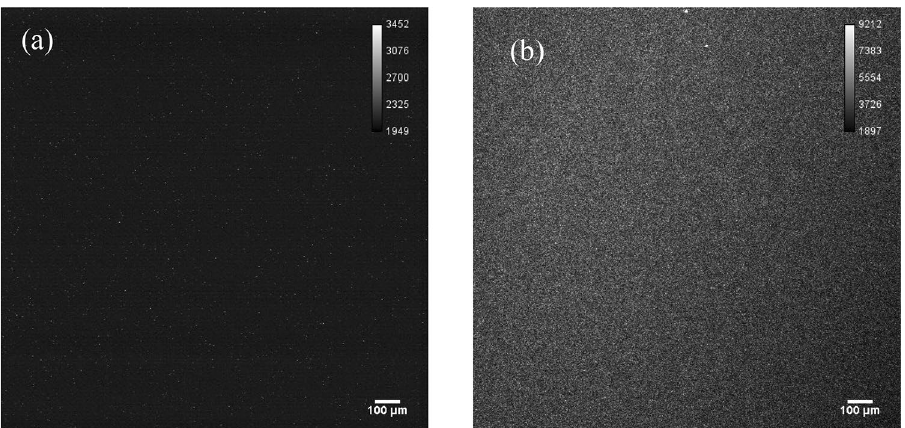
Figure 4. Image of an alpha particle from the active area of the 90 Sr/ 90 Y beta source obtained with the zoom range of 5 × using ( a ) the 50-ms sequence mode and ( b) the 10-min acquire mode. No spot is observed. The images of using the “Sequence mode” with 50-ms intervals can be found as Supplementary Fig. S2